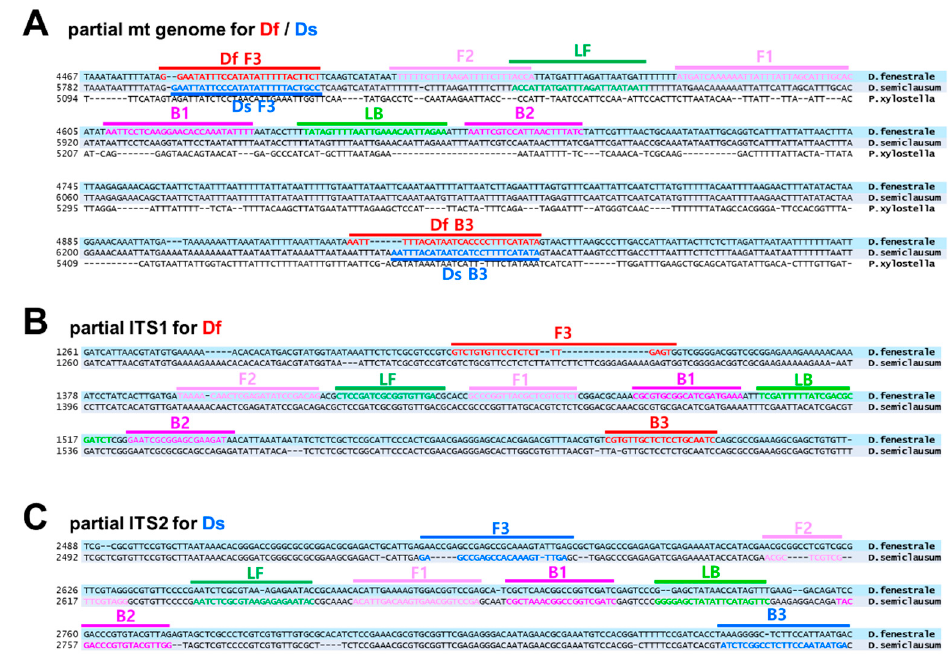
Figure 2. Location of primers and primer binding regions on the partial sequences of mitochondrial genomes from Df and Ds, and additional DBM. Three sequences are aligned in ( A ), and two sequences are aligned in ( B ) and ( C ); these were used to pick species-specific regions for primer design. F3 and B3 are the main diagnostic primers. The inner primer, FIP, consists of F1c (complementary sequences of F1) and F2. The other inner primer, BIP, is composed of B1 and B2c (complementary sequences of B2). The four essential LAMP primers (F3, FIP, BIP, and B3) generate a dumbbell structure, and the two loop primers, LF and LB, accelerate the LAMP reaction. Df, Diadegma fenes- trale ; Ds, Diadegma semiclausum ; DBM, diamondback moth; LAMP, loop-mediated isothermal am- plification.